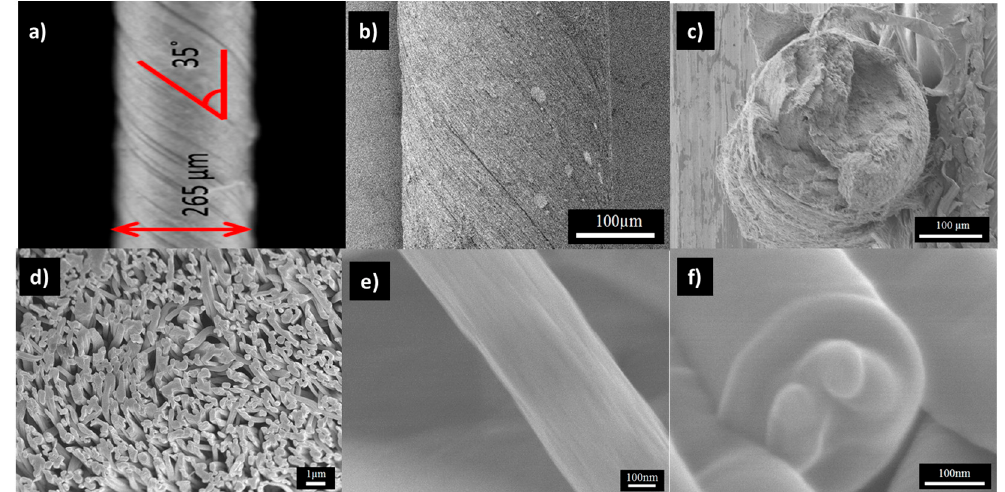
Figure 4. As-prepared electrospun nanofibres: ( a ) surface optical microscopy; ( b – d ) longitudinal and cross-sectional SEM images of the PAN/LCGO-D nanofibrous twisted yarn, respectively. ( e , f ) longitudinal and cross-sectional FESEM images of individual PAN/LCGO-D nanofiber, respectively.